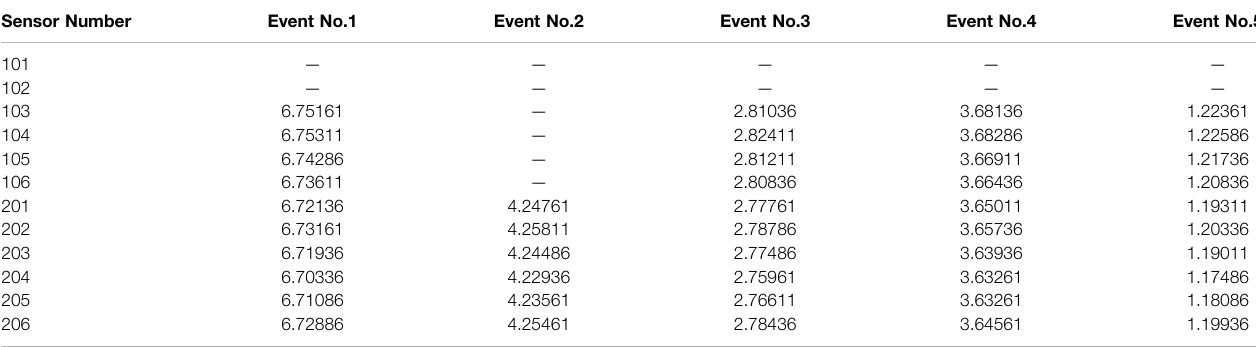
TABLE 5 | Arrival time of the sensor for the blasting test event.